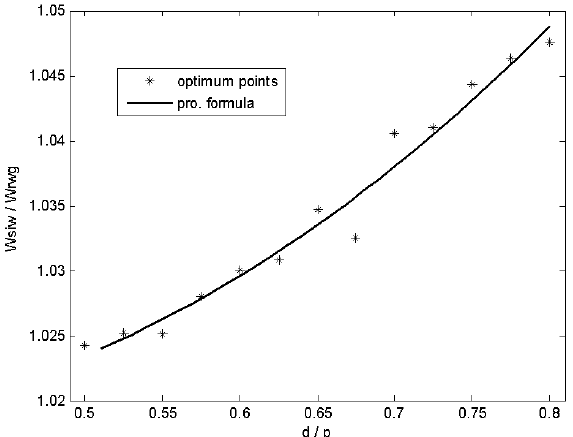
Figure 3: Optimum ratios giving the closest cutoff fre- quency for fc=6.653 GHz and (cid:15) r = 2 . 33 square approach is used to approximate this curve by the formula (10). Good accuracy of the formula is obtained; the relative error is about 1%. W SIW = W eq × (0 . 1172(